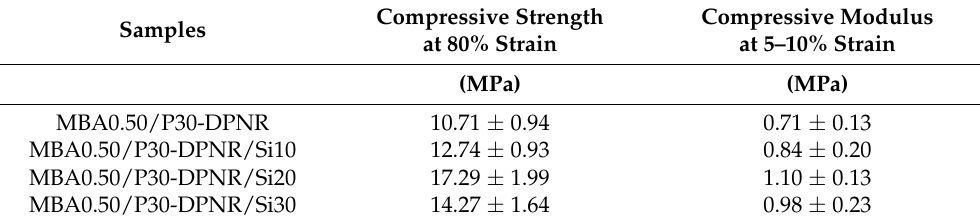
Table 3. Compressive properties of M0.50/P30-DPNR/silica composites with various silica